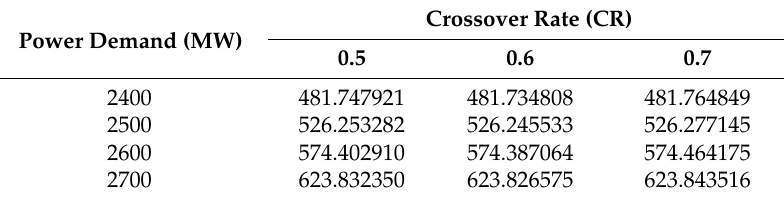
Table 10. Simulation results for various values of Crossover